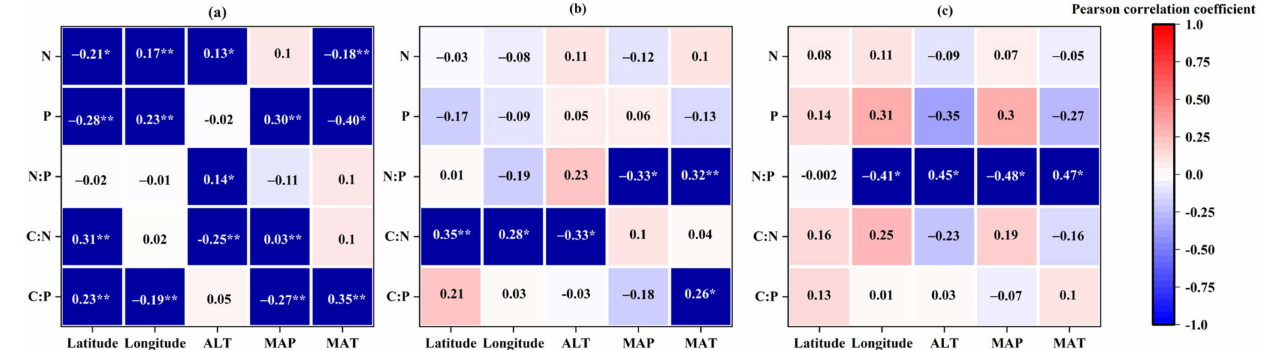
Figure 6. Heat map of Pearson’s matrix of correlation coefficients between leaf stoichiometry and geographical and climatic factors for different life forms. ( a – c ) represent the correlations of woody plants, herbs, vines with geographical and climatic factors, respectively. * and ** represent significant correlations at p < 0.05 and p < 0.01, respectively. ALT, MAP, and MAT represent altitude, mean annual precipitation, and mean annual temperature,